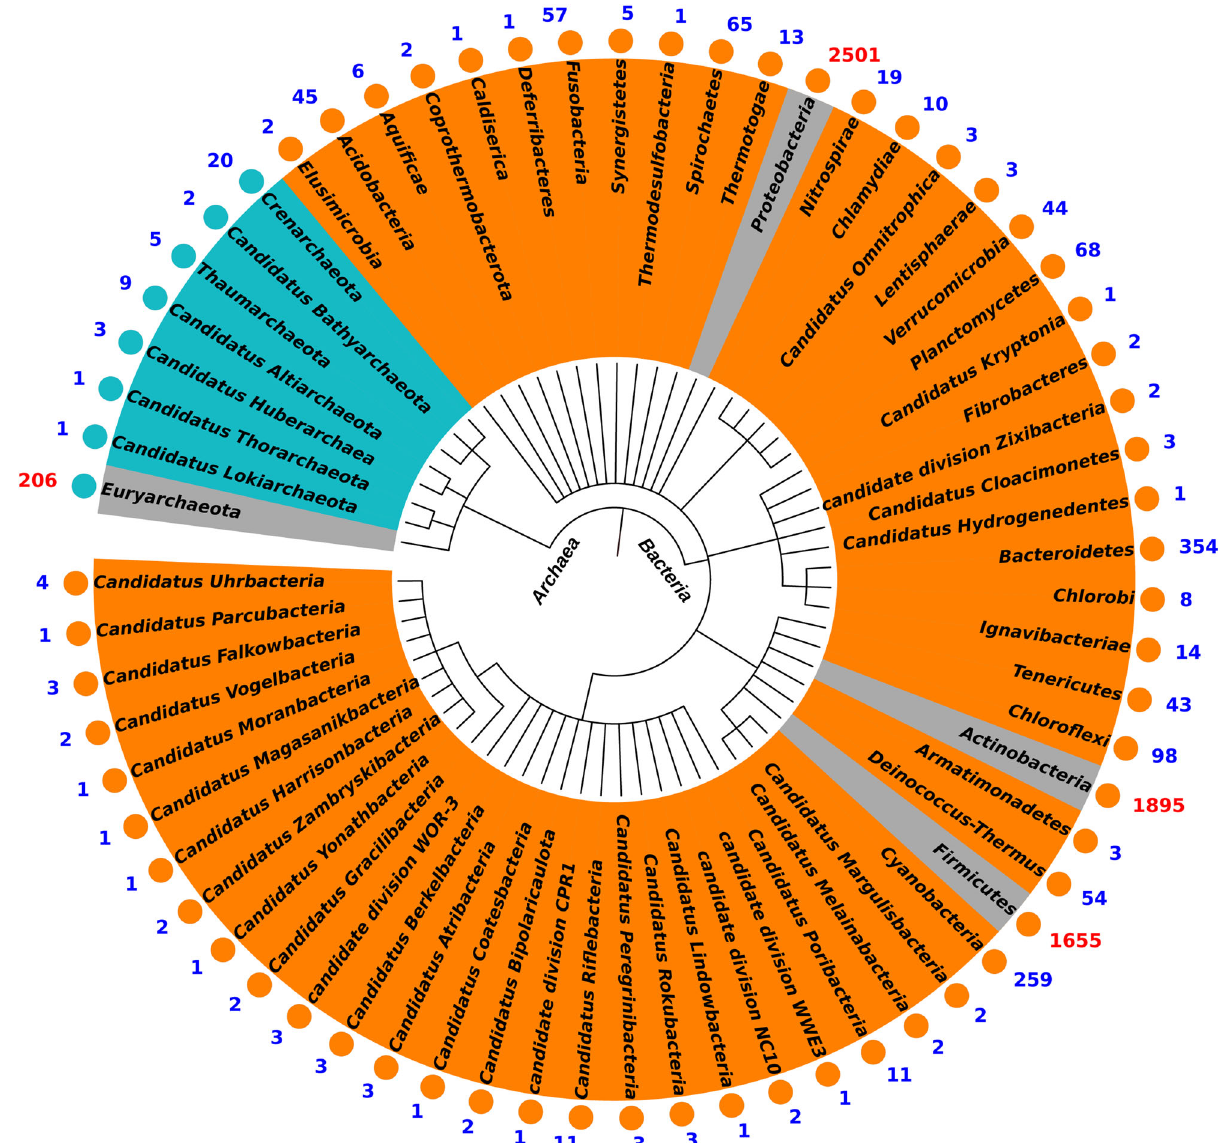
Fig. 3 Taxonomy of predicted hosts of viral contigs from all samples at phylum level. Eight phyla of archaea and 58 phyla of bacteria were shown in the graph. Green dots represented archaea and orange dots represented bacteria. The top three bacteria and top one archaea that could be infected by most viruses were highlighted with a gray background. Source data are provided as a Source Data fi